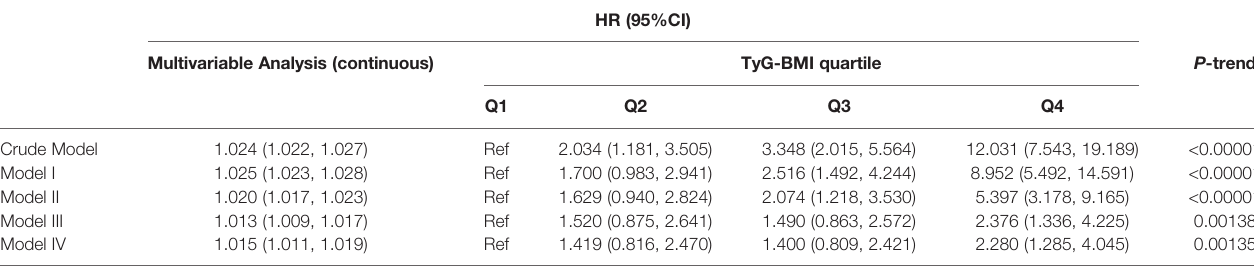
TABLE 2 | Associations of baseline TyG-BMI with incident T2DM.